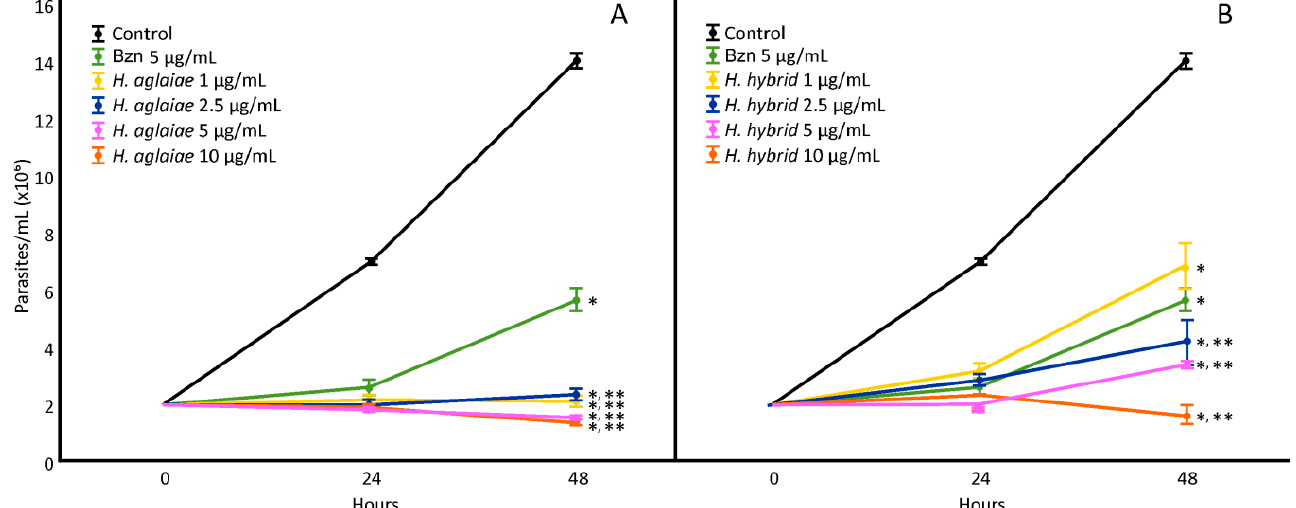
Figure 1. Effect of the H. aglaiae BARE ( A ) and H. hybrid BARE ( B ) on T. cruzi epimastigote proliferation at concentrations of 1, 2.5, 5, and 10 µg/mL. *: Significant difference from negative eration at concentrations of 1, 2.5, 5, and 10 µ g/mL. *: Significant difference from negative control; control; **: significant difference from positive control. p < 0.05. **: significant difference from positive control. p < 0.05.